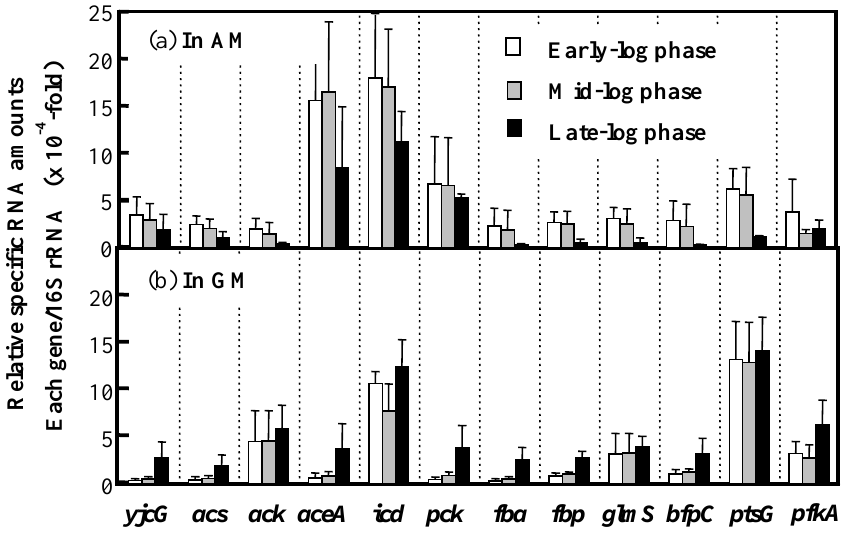
Figure 9. Relative gene expressions in the cells of C. freundii IFO 13545 grown in AM (on acetate) ( a ) or GM (on glucose) ( b ) compared to that of the 16S rRNA gene. The cells were grown in AM or GM and harvested at O.D. 600 = 0.52, 1.15, and 2.00 (early-, mid- or late-log phase, respectively). RNA samples were extracted from the cells and qRT-PCR was conducted using specific paired primers for each gene (Table 1). The average ± the standard deviation of the values obtained in three repeated experiments is shown. The relative amounts of RNA from the 16S rRNA gene in AM were 3.27 × 10 − 2 (early), 2.63 × 10 − 2 (mid), and 3.88 × 10 − 2 (late), whereas the amounts in GM were 3.39 × 10 − 2 (early), 2.11 × 10 − 2 (mid), and 3.35 × 10 − 2 (late).